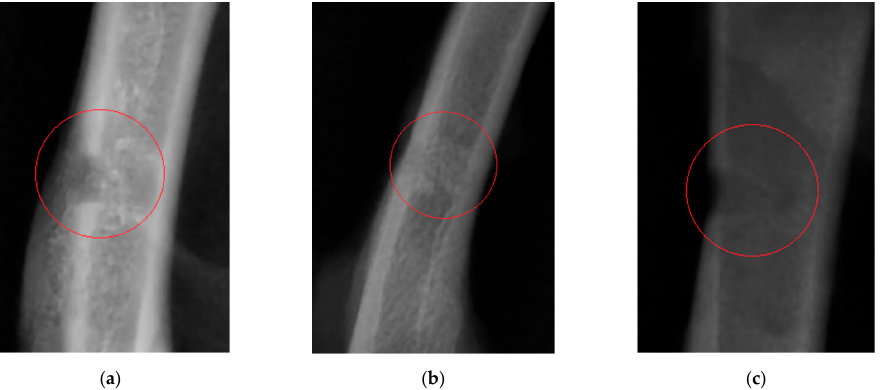
Figure 1. An X-ray image of the bone defect in rats on study day 21: ( a ) rats receiving the feed supplement containing silicon chelates; ( b ) rats receiving the feed supplement containing silicon chelates and vitamin D; and ( c ) rats receiving food without any supplements.